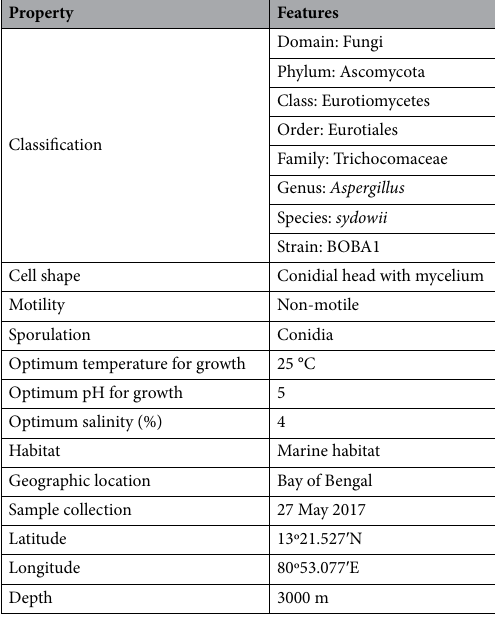
Table 2. Classification and general features of A. sydowii